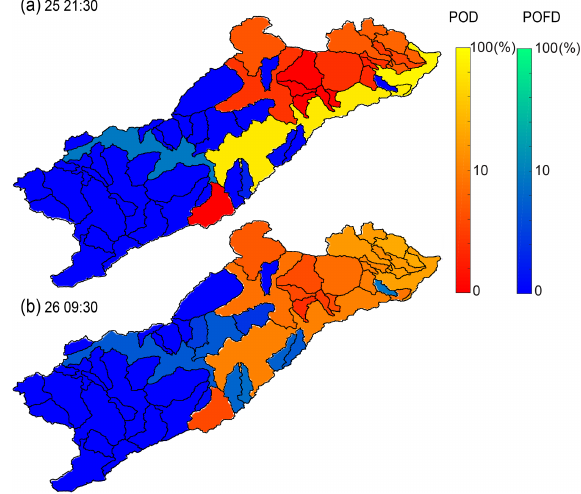
Figure 12. POD and POFD calculated for each subbasin between the reference run and the peak discharge on 26 April for the 1681 rainfall fields resulting from the spatial shifting of the forecast COSMO runs of (a) 25 April, 21:30 and (b) 26 April, 09:30. POD was calculated for each subbasin with reference categories of mod- erate or above, and POFD was calculated for each subbasin with reference categories of low or no flow (Fig.